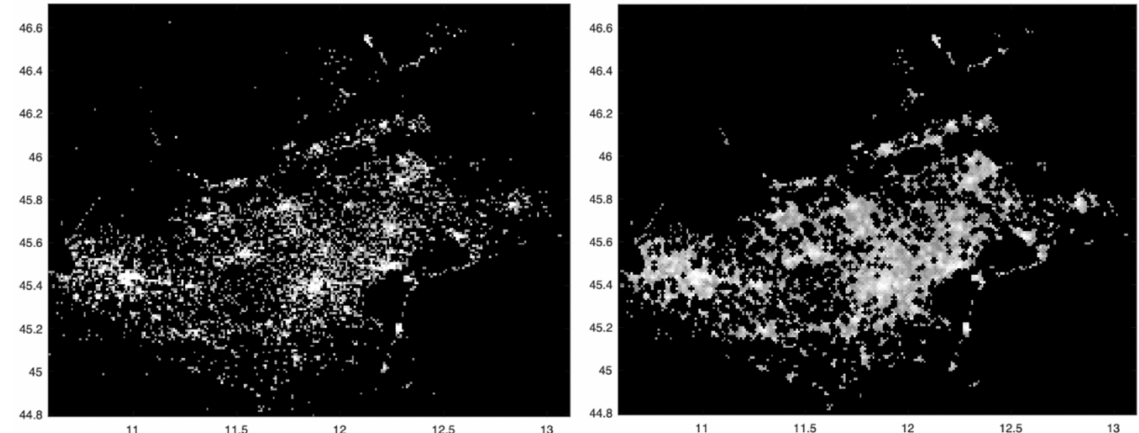
Figure 1. Left: spatial distribution of the SARS-CoV-2 incidence in the period from 12 March to 15 May 2020, in all 1 km squared cells covering the Veneto region. Darker pixels correspond to lower intensity values. To increase the contrast of the image, a non-linear mapping (fourth root) is applied. Outlier values with very high intensity were reassigned through the 0.993 quantile (low-pass filter). Right: mathematical morphology opening operator applied to the image in the left panel followed by removal of “isolated” points. The values along x and y axes refer respectively to longitude and latitude.